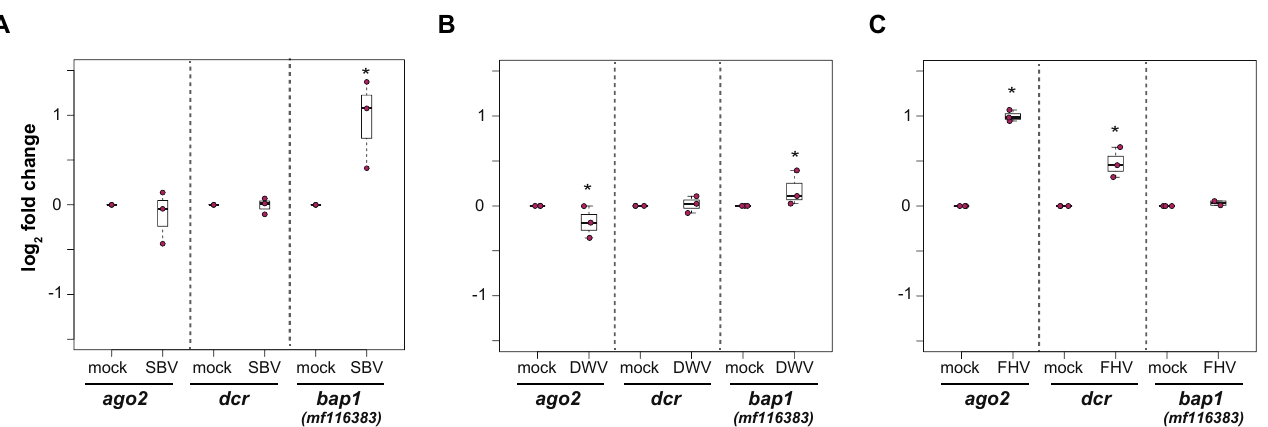
Figure 7. Virus infections of primary honey bee pupal cells differentially impact the expression of select immune genes. The relative expression of three honey bee immune genes, argonaute-2 (ago2), dicer-like (dcr-like) , and bee antiviral protein-1 (bap1)/mf116383 , were assessed by qPCR at 72 hpi. The ΔΔ Ct method with normalization to rpl8 was utilized to assess target gene expression in each sample, and then the log 2 fold change values were calculated relative to mock-infected samples. Raw data are included in Supplemental Tables S9–S11. ( A ) SBV infection of pupal cells did not impact ago2 or dcr-like expression, whereas the expression of bap1 was 0.95 log 2 -fold greater at 72 hpi ( p = 0.032). ( B ) DWV-infected pupal cells exhibited slightly lower ago2 expression ( p = 0.032) relative to mock-infected cells at 72 hpi, whereas there was no impact of virus infection on dcr-like expression. The expression of bap1 was 0.18 log 2 -fold higher in DWV-infected pupal cells compared to mock-infected cells at 72 hpi ( p = 0.032). ( C ) In pupal cells infected with FHV, ago2 and dcr-like expression was higher (i.e., 1 and 0.48 log 2 -fold change, respectively, p = 0.032) in FHV-infected cells relative to mock-infected cells at 72 hpi. The expression of bap1 was not impacted by FHV infection. The differences in log 2 immune gene relative expression in infected cells relative to mock-infected (PBS-treated) cells at 72 hpi were assessed using a one-sided Wilcoxon Rank Sums test. Significance level: * p <